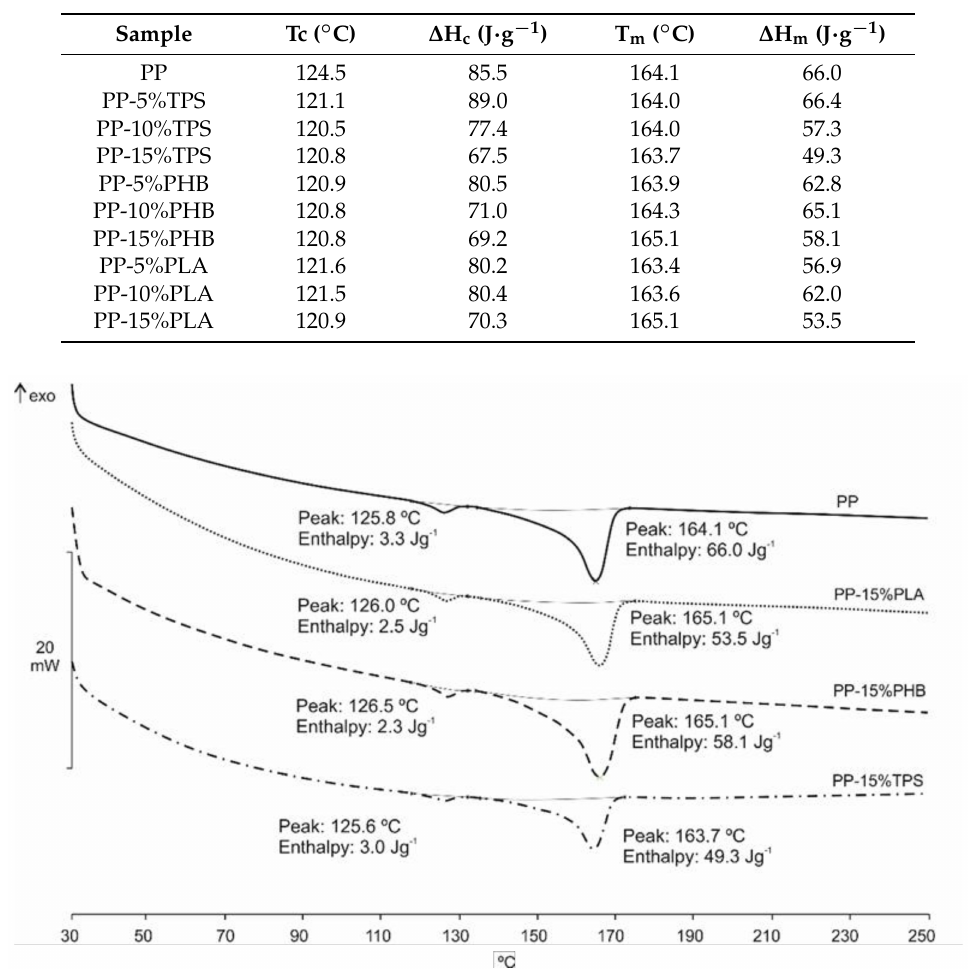
Figure 4. DSC curves of PP blends with 15 wt % of biodegradable